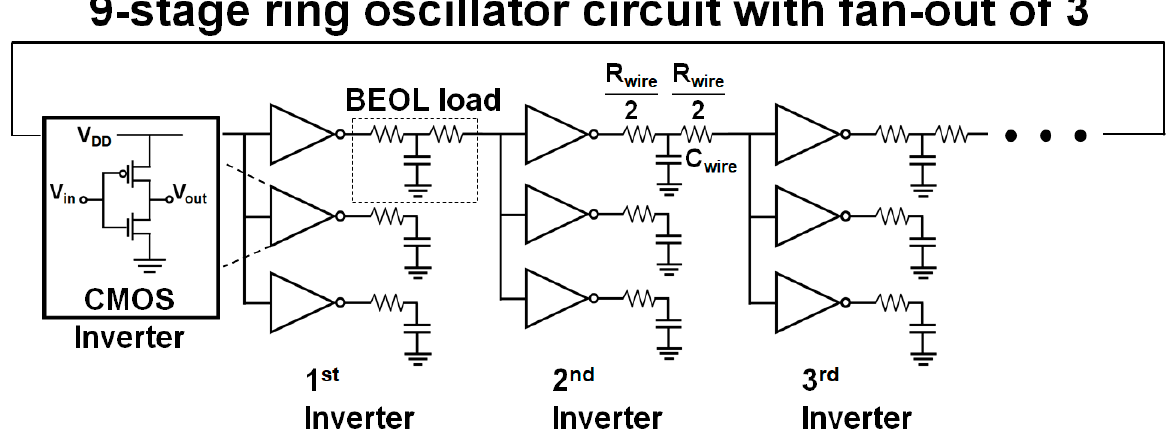
Figure 6. Nine stages RO schematic with fan-out of three.